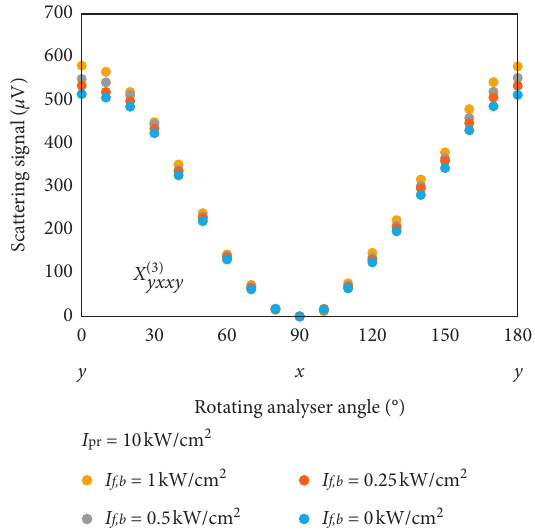
Figure 4: Vectorial DFWM beam coupling measured with a confocal microscope.